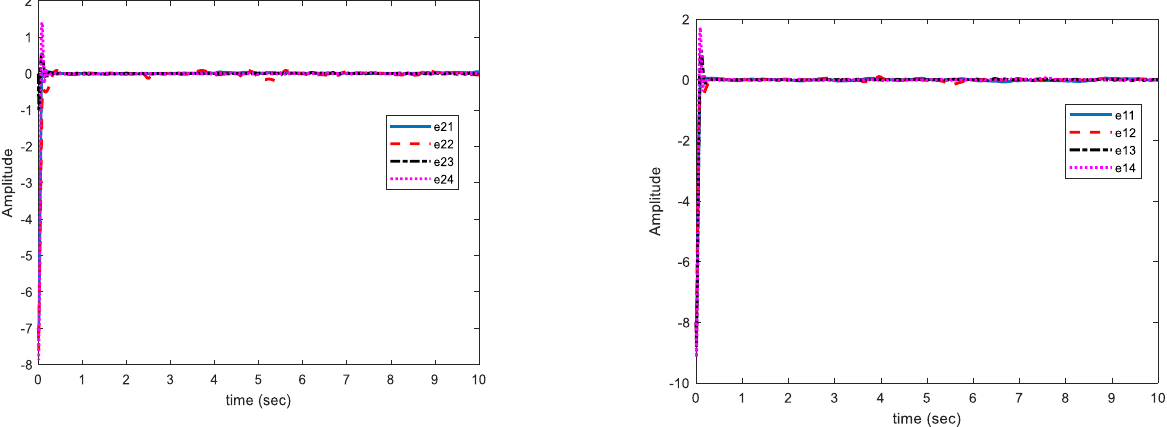
Figure 8. Curves of synchronization errors in case of disturbance and structural uncertainty of case (C).